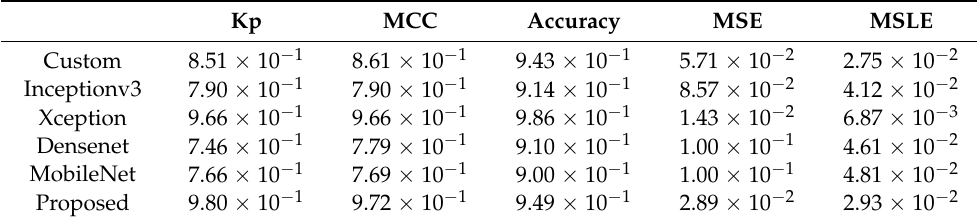
Table 3. The classification report for each of the models and the final model using the piston dataset. Kp